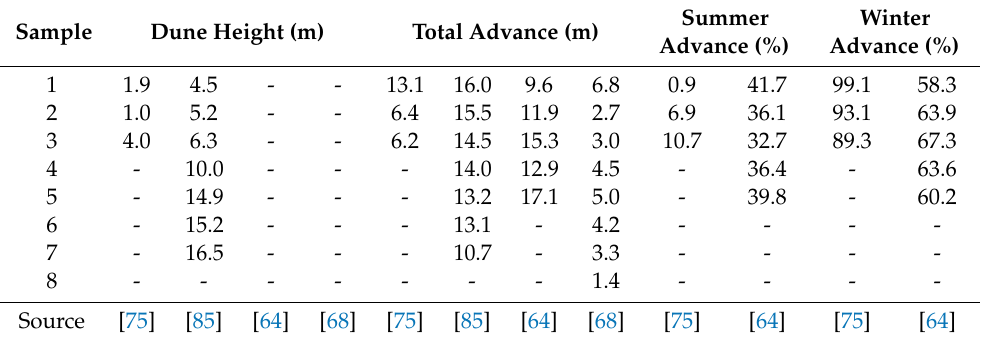
Table 5. Results of measurements on annual movement of barchan dunes, the North Sinai Sand Sea. Sample Dune Height (m) Total Advance (m)